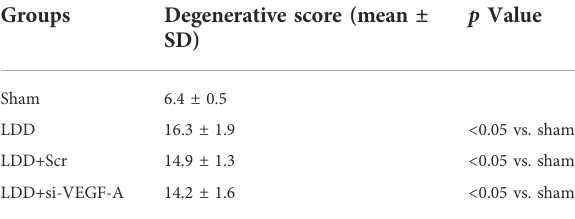
TABLE 2Histological LDD degenerative score. Groups